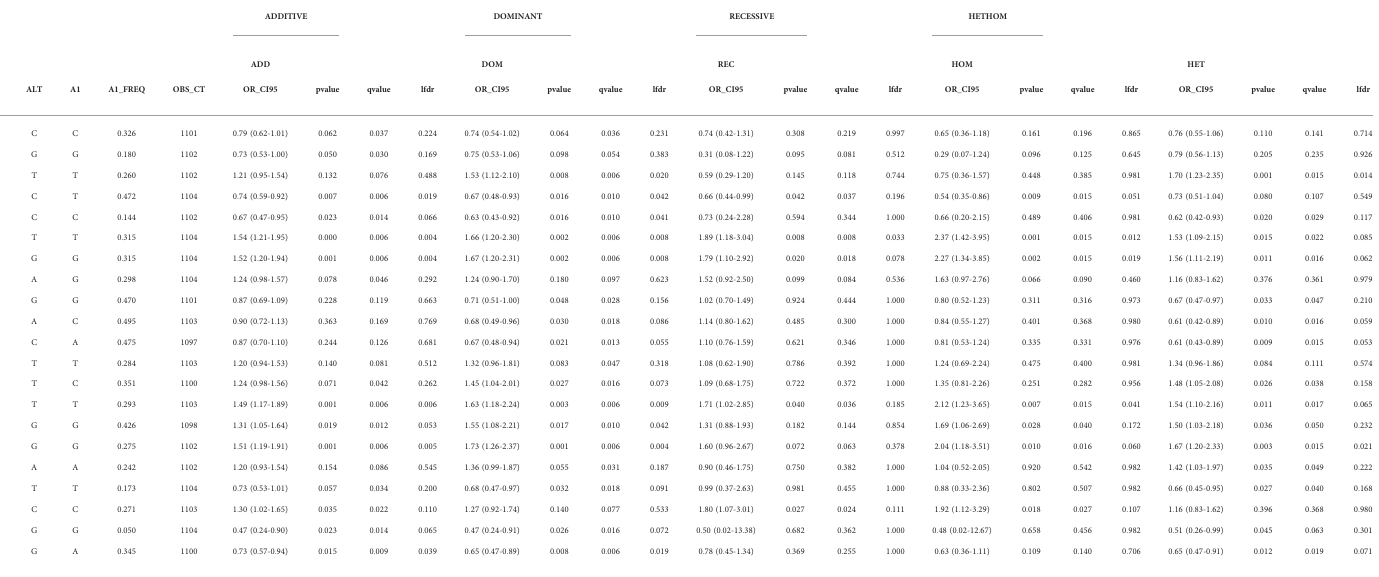
TABLE 3 CAU (SNP + GROUP) MODELS. SIGNIFICANT SNPs. CAUCASIAN.